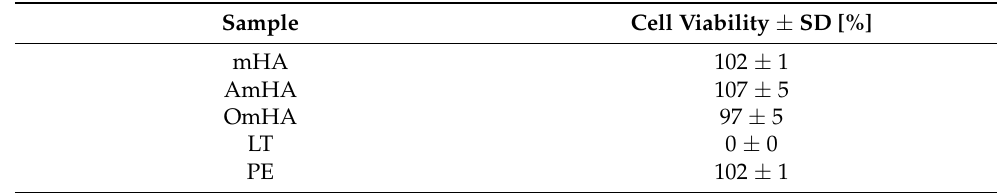
Table 2. Results of the neutral red uptake test for the highest concentrations of tested extracts [50 mg/mL] in comparison to the untreated control. The test was conducted for up to 24 h. Sample